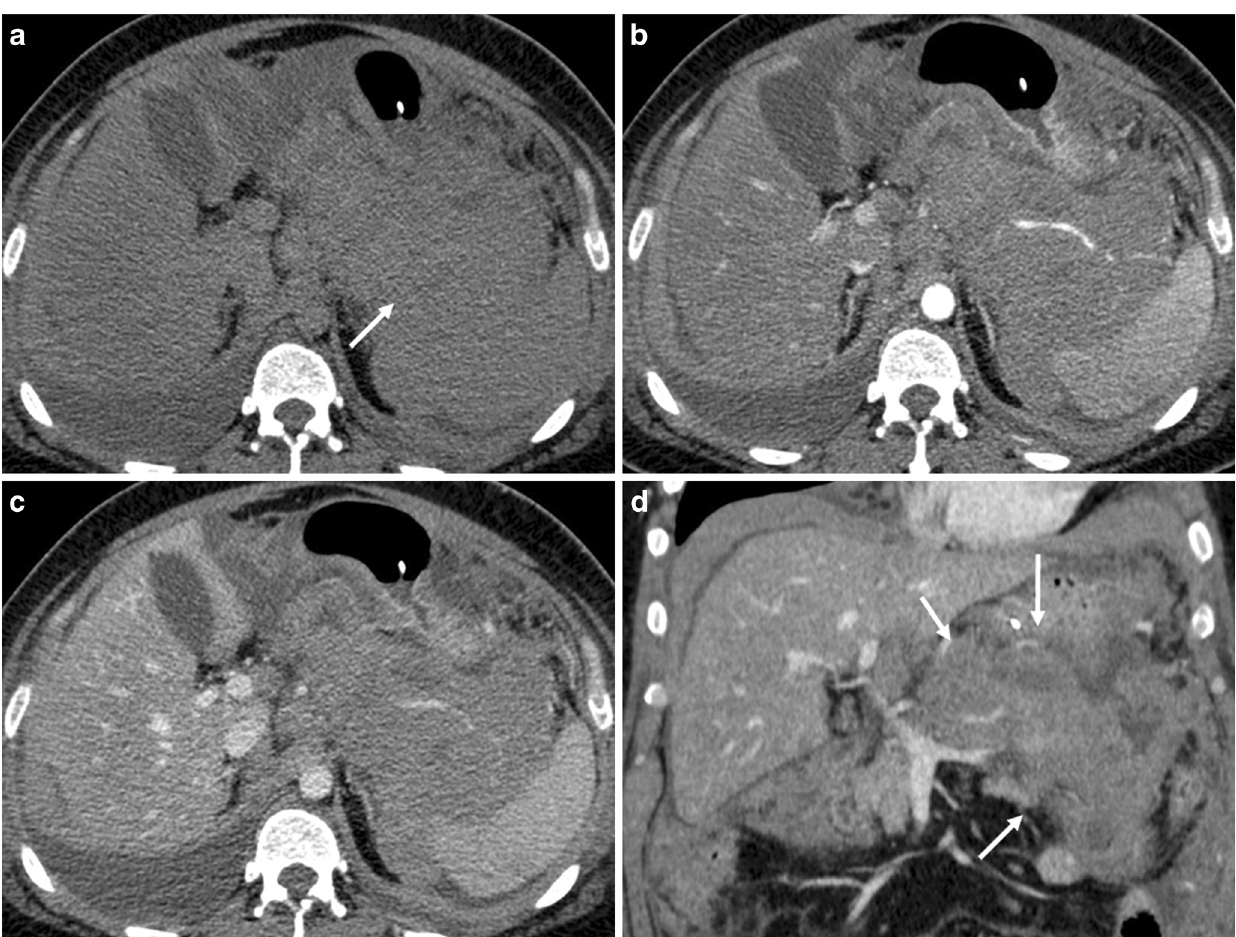
encasesit. b,c CTimagesaftercontrastmediumadministrationinthearterial- pancreatic phase ( a ) andportal-venous phase ( b ): the neoplasm is hypodense, with progressive contrast enhancement. d. This coronal CT reconstruction allows better appreciation of the size and extension of the lesion (arrows)